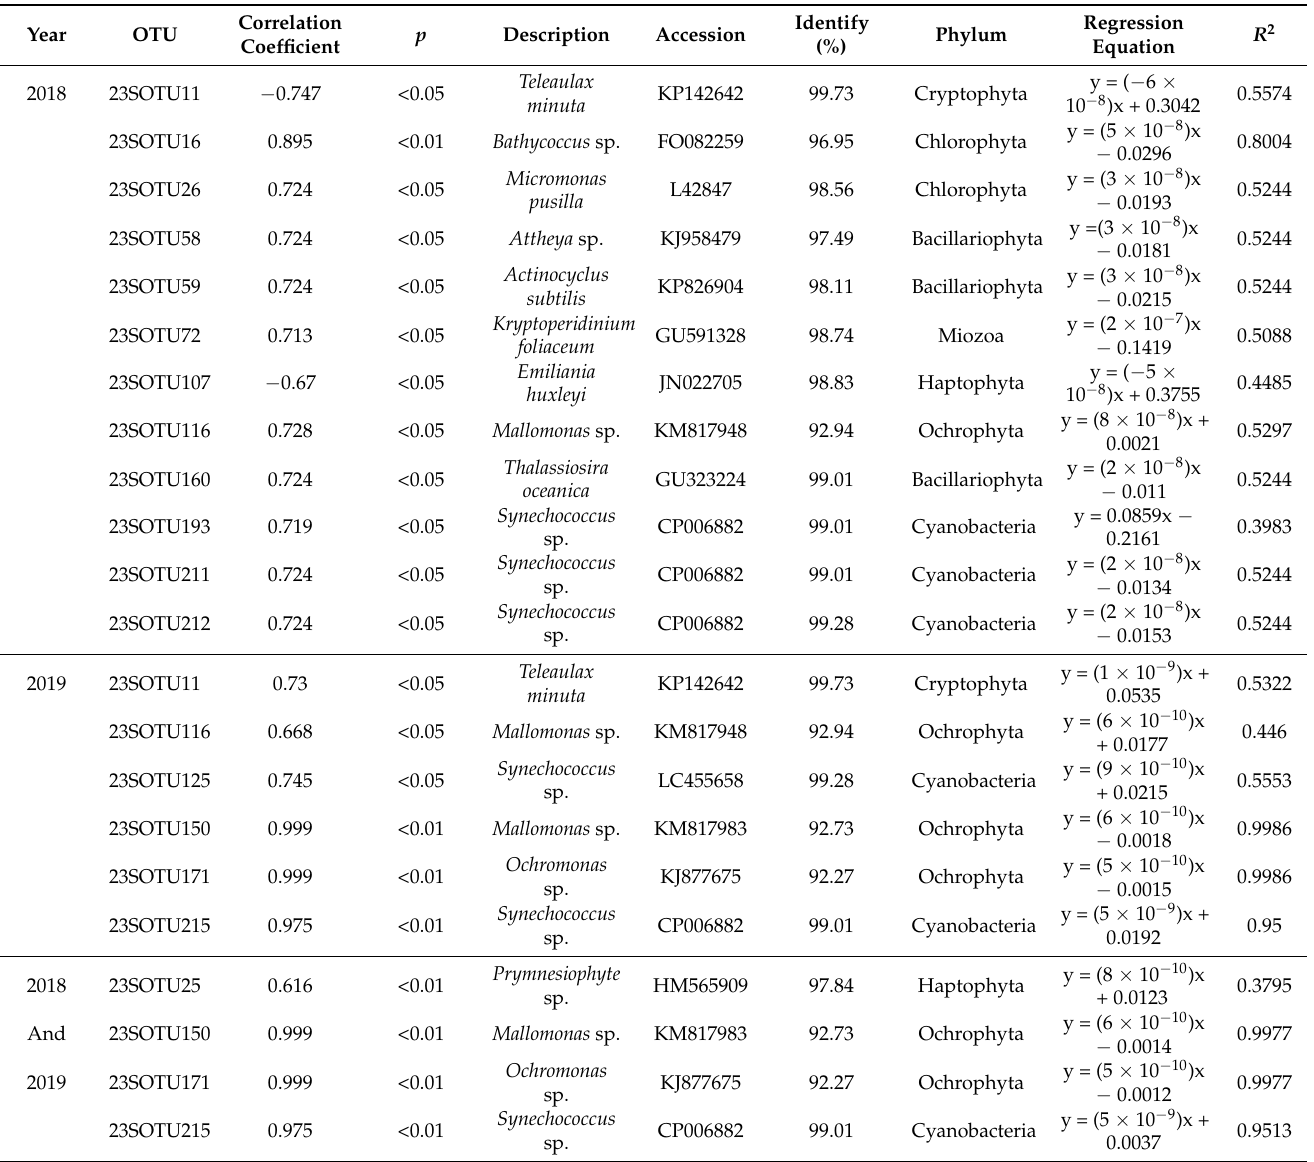
Table 8. Strongly correlated phytoplankton OTUs with C. polykrikoides